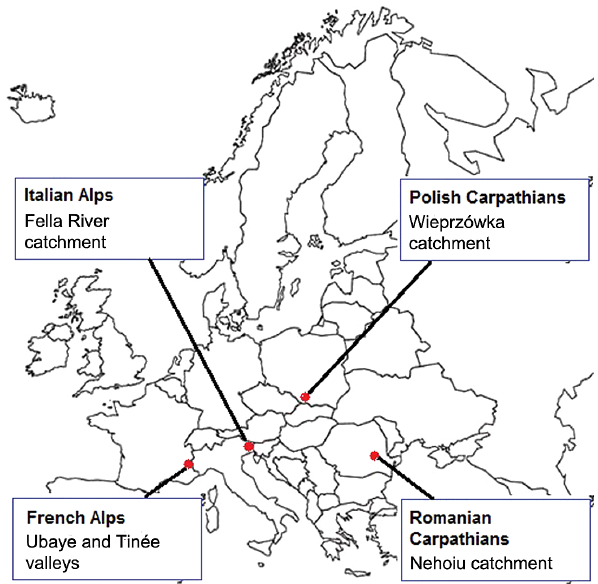
Figure 1. Location of study areas.